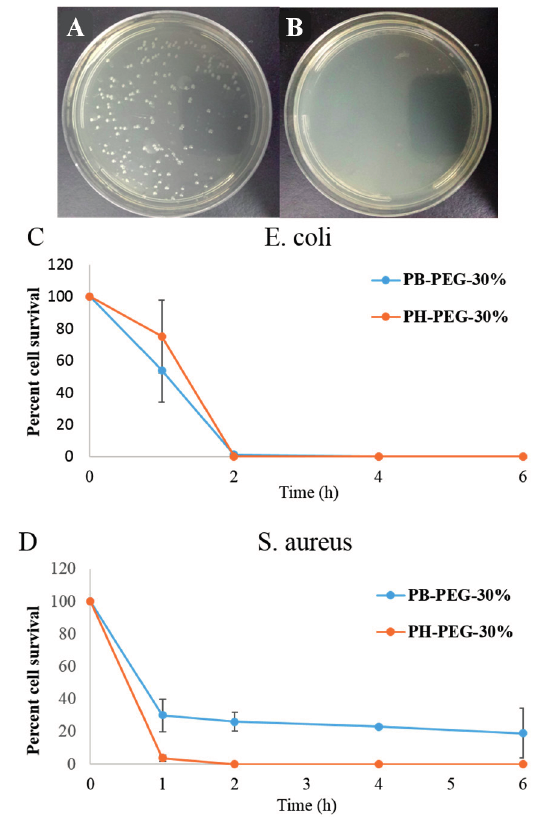
Figure 3. E. coli colony forming units (CFUs) after treatment with PB-PEG-30% at ( A ) 0 h and ( B ) at 6 h time interval. Time dependent killing efficiency of PB-PEG-30% and PH-PEG-30% copolymers at 1 × MIC concentration against ( C ) E. coli and ( D ) S. aureus . PB-PEG-30% and PH-PEG-30% terpolymers incorporate approximately 30 mol % of PEGMA-300. Error bars represent standard